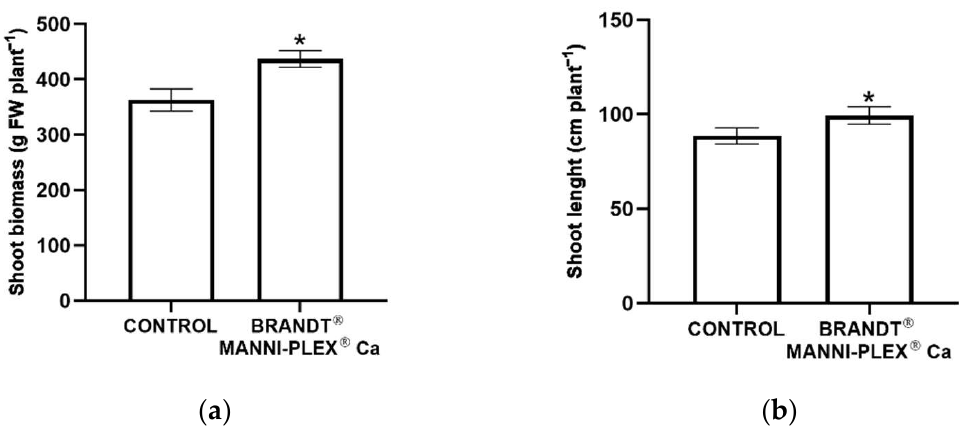
Figure 1. Effect of BRANDT ® MANNI-PLEX ® Ca application on the vegetative biomass ( a ) and length of the shoot part ( b ) of pepper plants. Values are expressed as means ± standard error ( n = 12). The level of significance was represented by p < 0.05 (*).